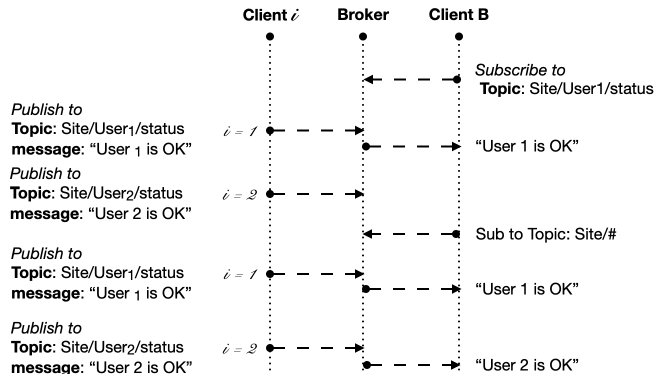
Figure 3. Publishers and subscribers, examples without and with wildcard.